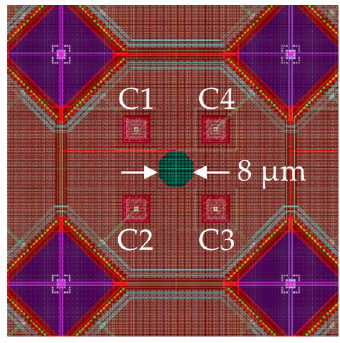
Figure 2. Plan view design drawing of an integrated circuit (IC) astrolabe unit cell.